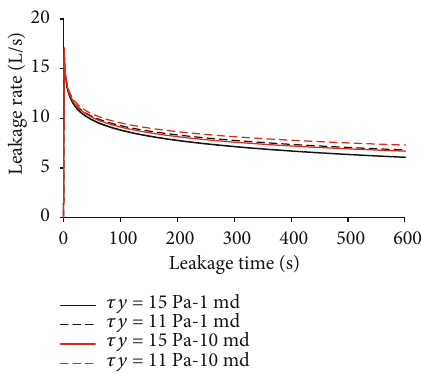
Figure 14: Leakage rate under di ff erent formation permeability and yield stress.